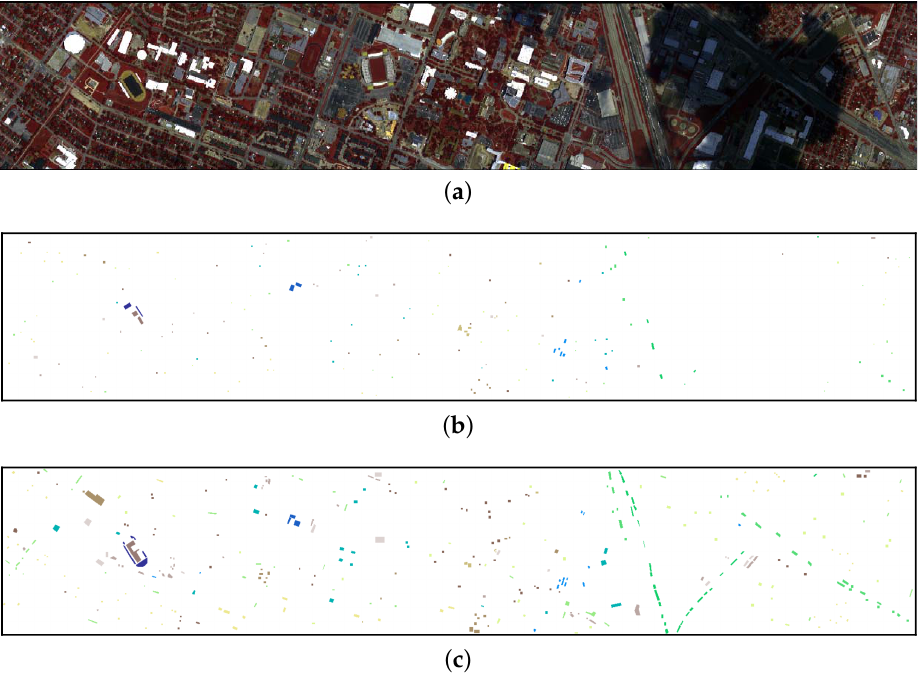
Figure 9. UH dataset. ( a ) False-color image. ( b ) Training samples distribution map. ( c ) Test samples distribution